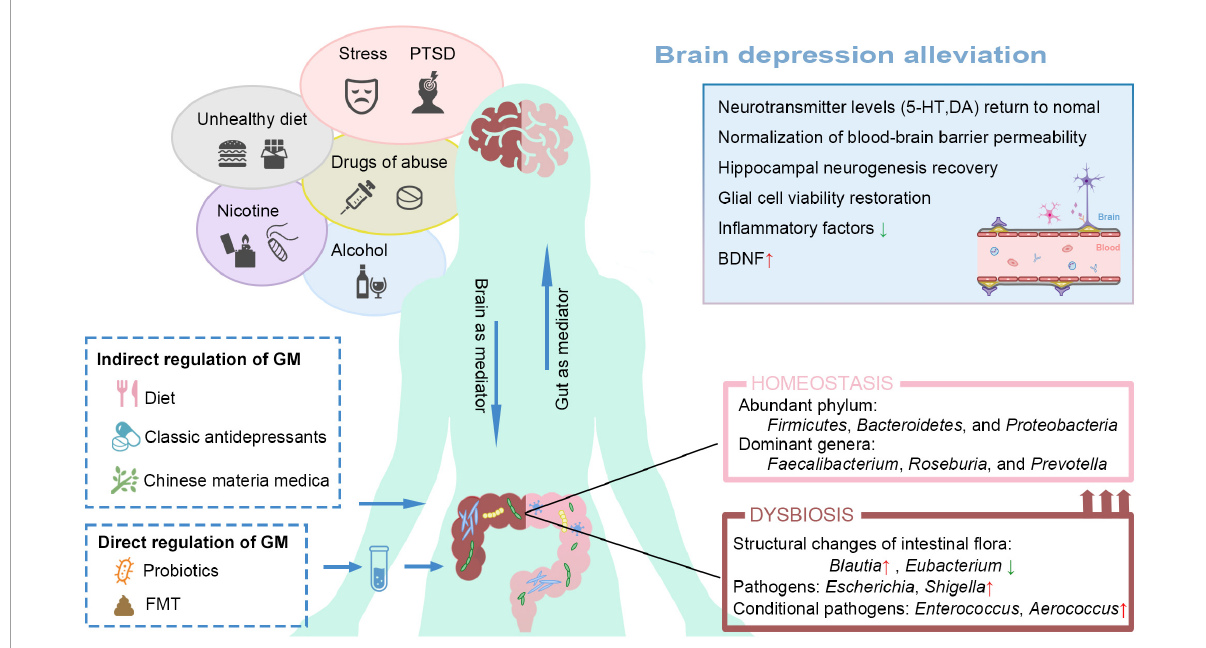
FIGURE2 Ameliorates depression from the perspective of restructuring the GM. Poor lifestyle habits and external stressors can increase the risk of depression. MDD patients also exhibit gut dysbiosis. Restore intestinal homeostasis can be restored through direct or indirect regimens,